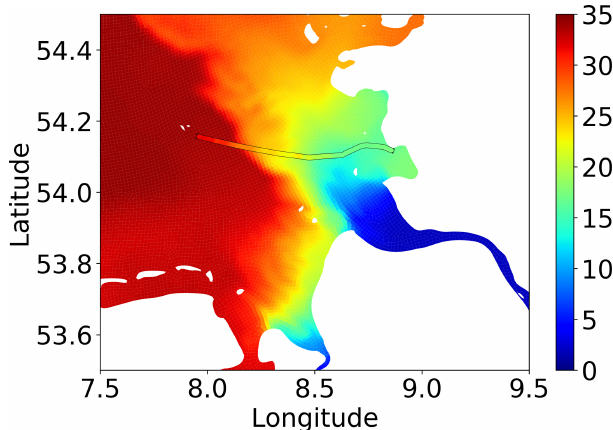
Figure 13. Sea surface salinity on 26 June 2013. Filled contours are model results, and colored lines are observational data from Ferry- Box (FunnyGirl) (Petersen,